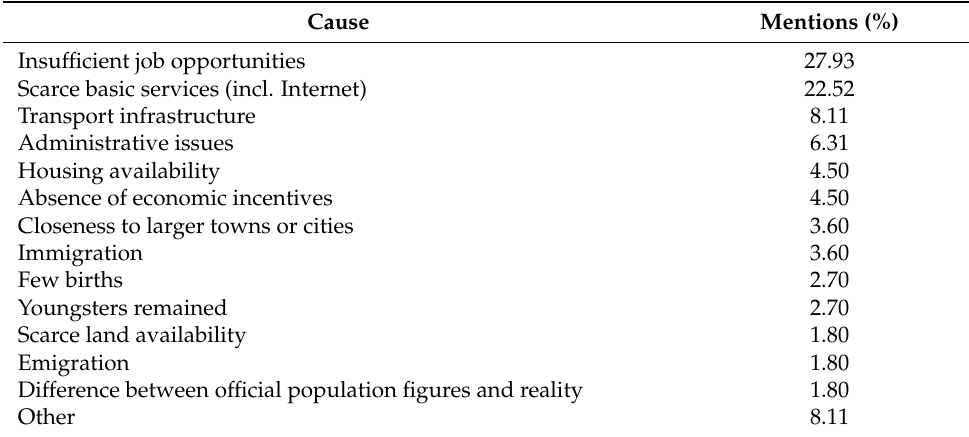
Table 3. Stated causes for the depopulation figures in protected municipalities, according to local residents.